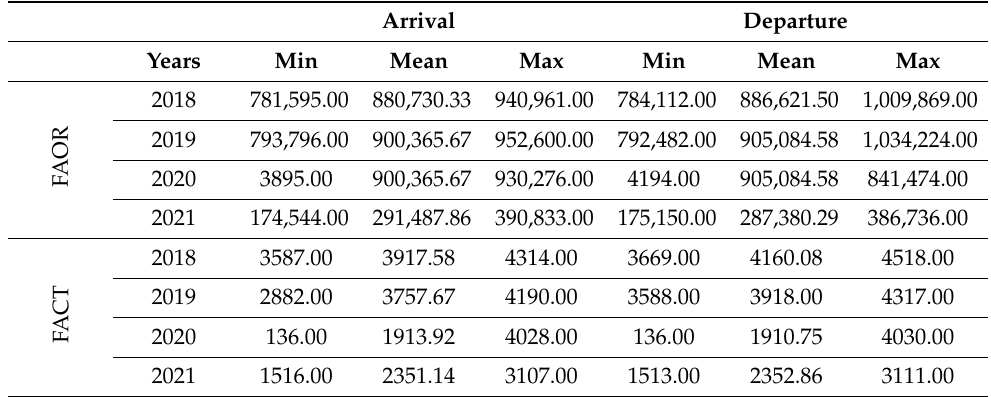
Table 2. Summary statistics of aircraft and passenger movements in OR Tambo International Airport and Cape Town International